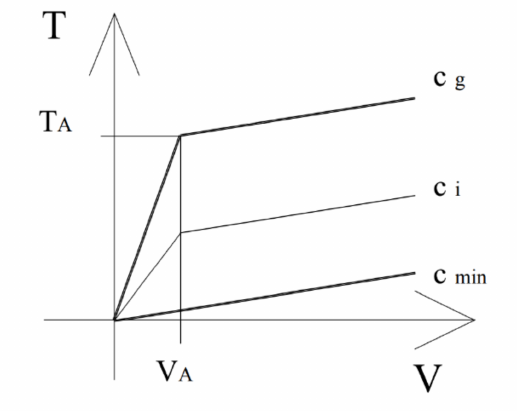
Figure 10. Adopted characteristic of the MR damper, T—friction force, v—velocity of damper deformation, c min —minimum value of the damping coefficient, c g —maximum value of the damping coefficient, c i —i-th value of the damping coefficient, T A —value of the friction force at point A, V A —value of the velocity of damper deformation at point